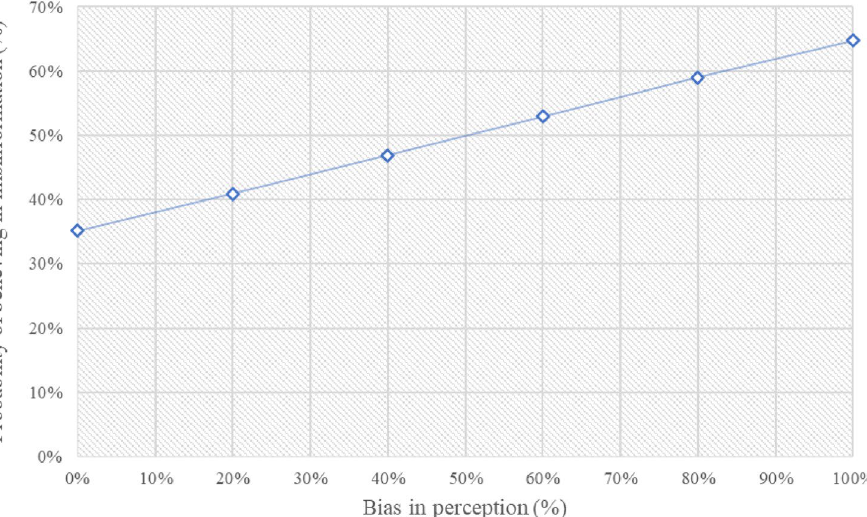
Figure 2. Relationship between bias in perception and probability in believing in misinformation. * Note The estimates in the figure refer to a probit panel data model (i.e., Model II of Table 1), with robust standard